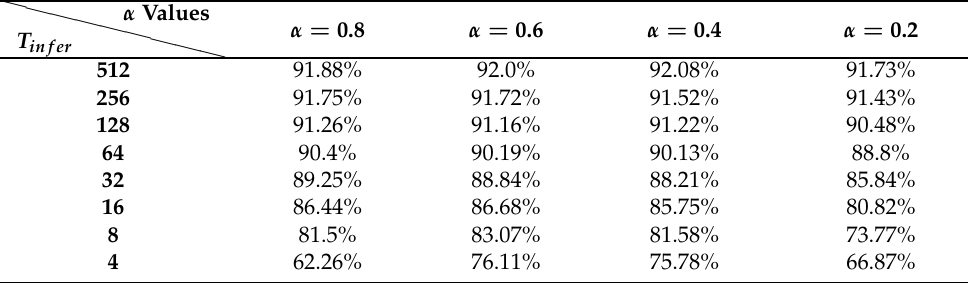
Table A3. Classification accuracy versus latency with differently scaled thresholds on the Fashion-MNIST